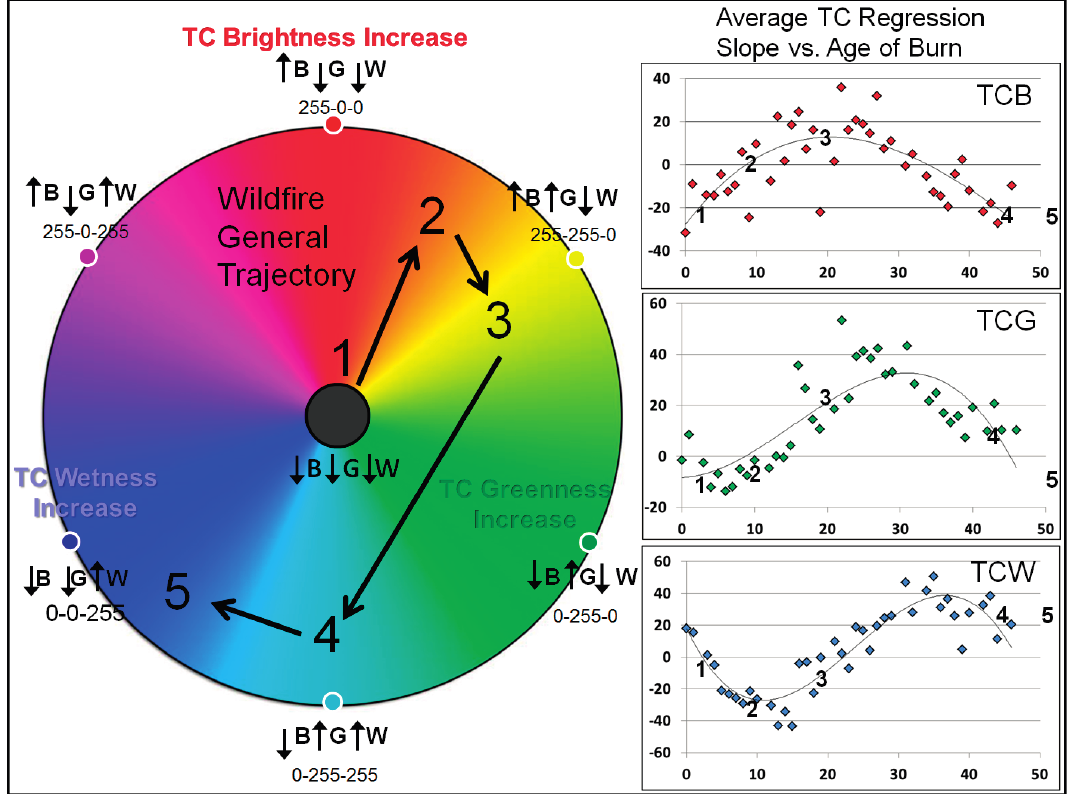
Figure 5. General trajectory of regenerating wildfires in RGB trend space from recently burned forest (1), expanding broadleaf cover (2–3) and succession towards needleleaf species (4–5). Also shown are the linear regression TC slopes averaged by age of burn with third-order polynomial curves overlaid to show the shape of the trajectories. The three TC slope values on the graphs are combined to generate the RGB colour trajectory (left) labelled as